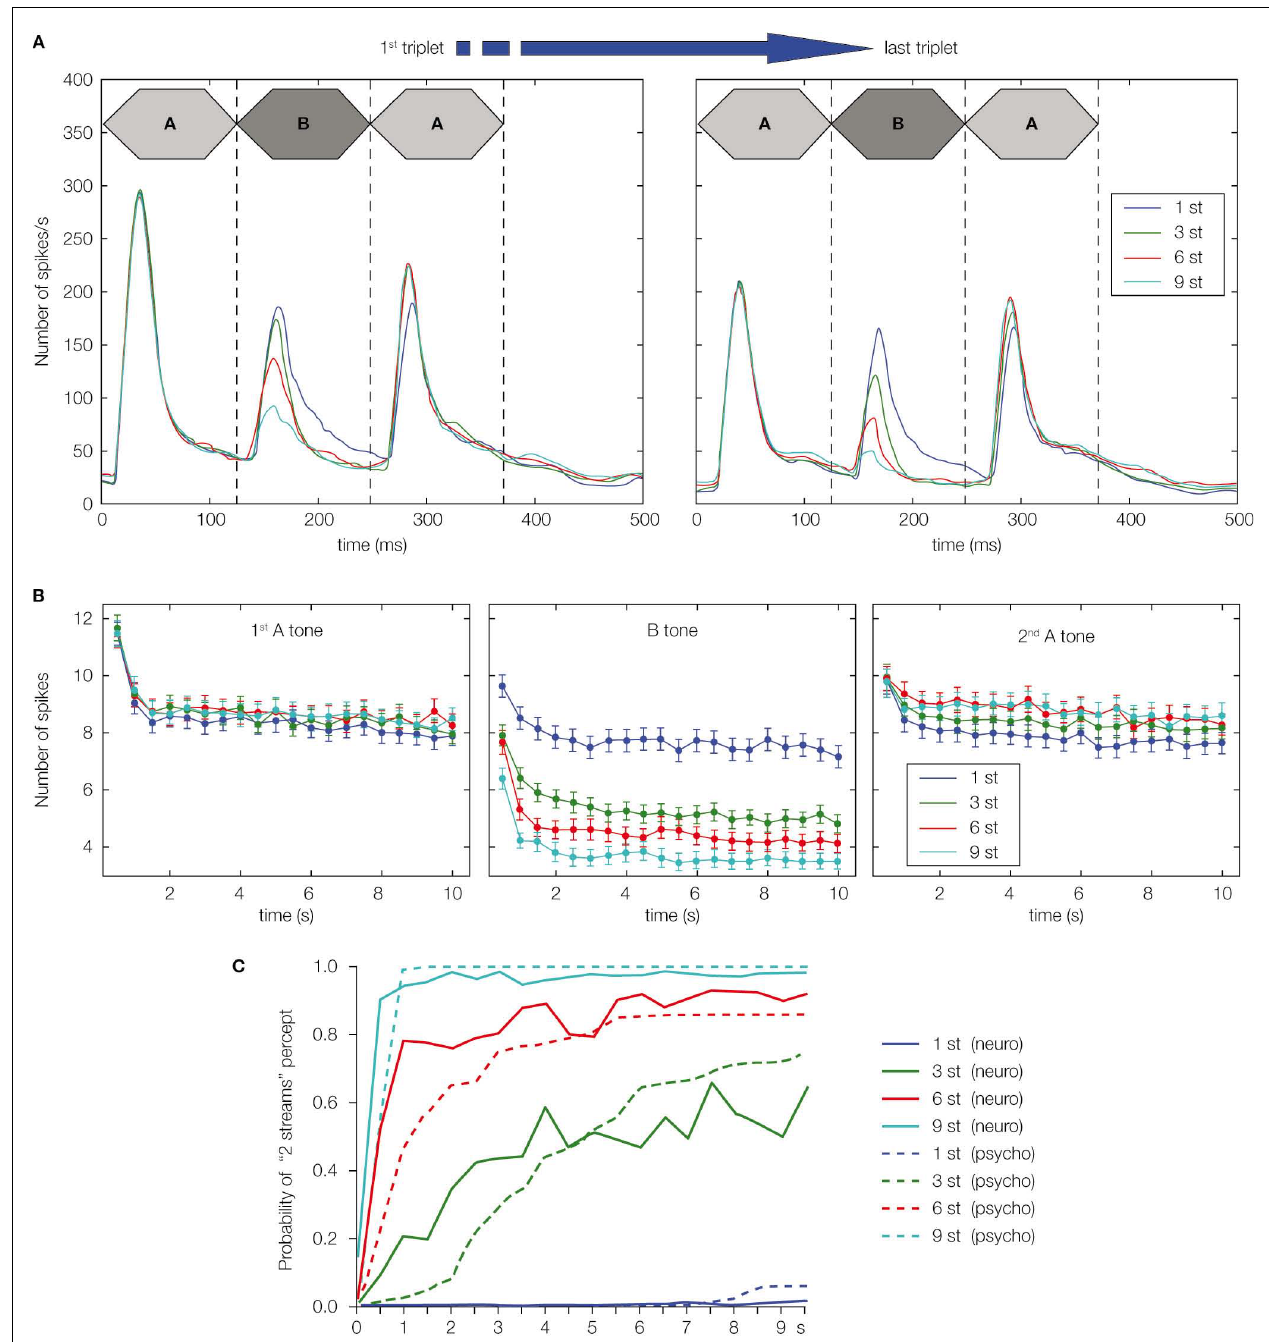
mechanisms. (C) Comparison between neural responses in macaque primary auditory cortex and percepts in humans with frequency separation from 1 to 9 st. The probability that the neural response to B tones exceeds a specifi c threshold was used as an estimate of the probability that the sequence is perceived as two streams by macaques (neurometric functions, solid lines). The probability that the sequence is perceived as two streams by humans was computed from behavioral measures (psychometric functions, dashed lines). Neurometric and psychometric functions share the same trend as a function of time and frequency separation. Reprinted from Micheyl et al. (2007), Copyright (2009), with permission from